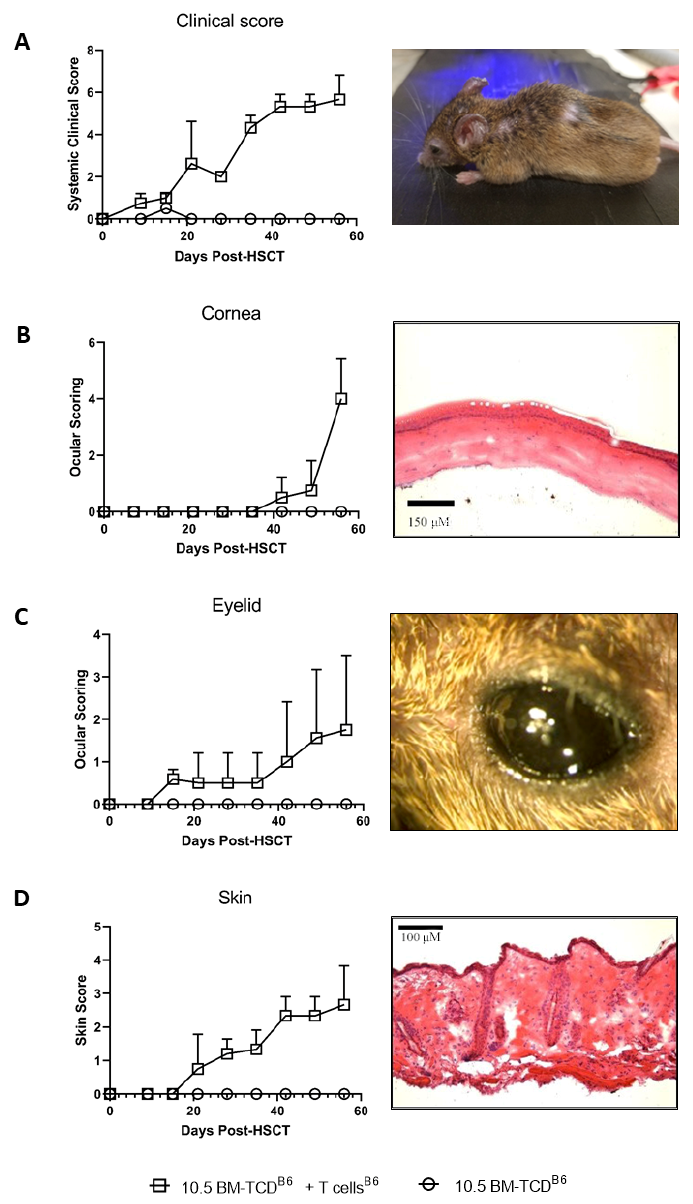
Figure 2. Correlation of the development of ocular and skin GHVD in MHC-matched HSCT recipients. Correlation between cutaneous and ocular tissue involvement (plotted as mean and SD) following MHC-matched (B6 → C3H.SW) allogeneic transplant of donor bone marrow (T-cell depleted—TCD- BM) +/ − T cells. Mice (n = 5/group) were transplanted with donor B6 TCD-BM alone did not exhibit detectable changes in the skin or ocular compartment. Recipients of B6 TCD-BM + T cells initially exhibited a systemic clinical score ( A ) and then cutaneous GVHD ( B ) and ocular GVHD